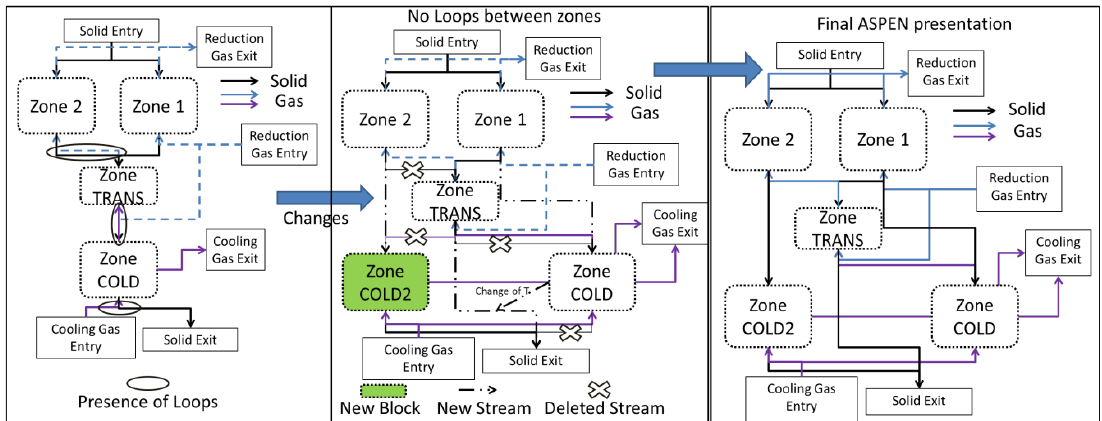
Figure 4. Restructuring of Aspen Plus configuration of the shaft furnace to avoid loops.